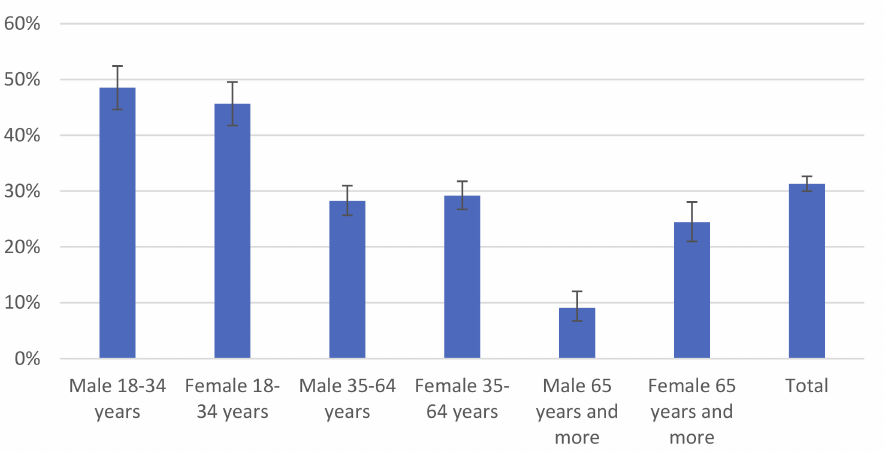
Figure 3. Percentage of respondents who declared lack of willingness to vaccinate against